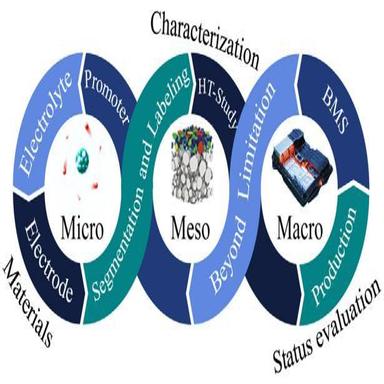
Scheme of ML assisted MIBs development at various scales.